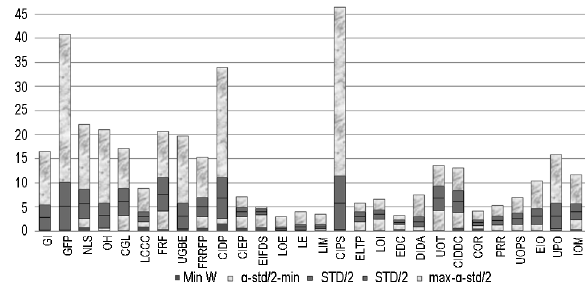
Fig. 4. Group composite attribute weights with range of individual composite